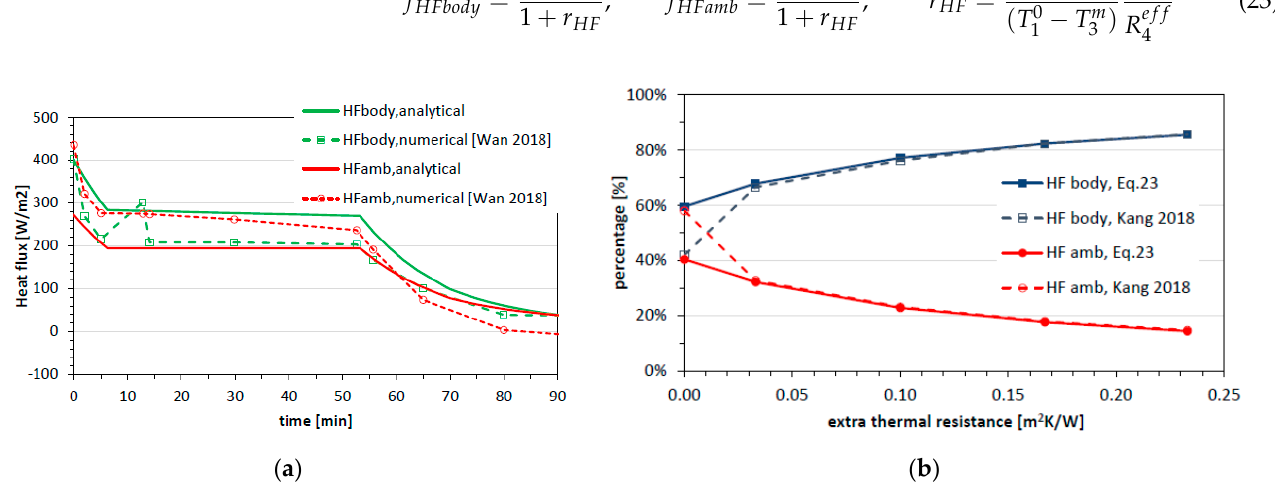
Figure 6. ( a ) Heat absorbed by the PCM from the body (green lines) and environment (red lines); Full lines: analytical model, dashed lines: numerical [23]; ( b ) Effect of extra insulation of PCM outer surface on body cooling efficiency. Full lines: analytical solution Equation (23), dashed lines